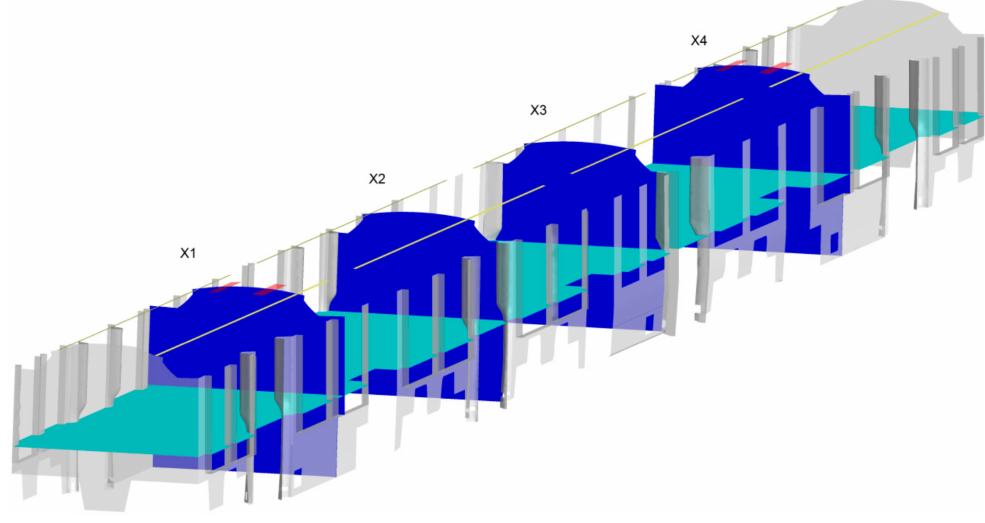
Figure 4. Selected horizontal and vertical